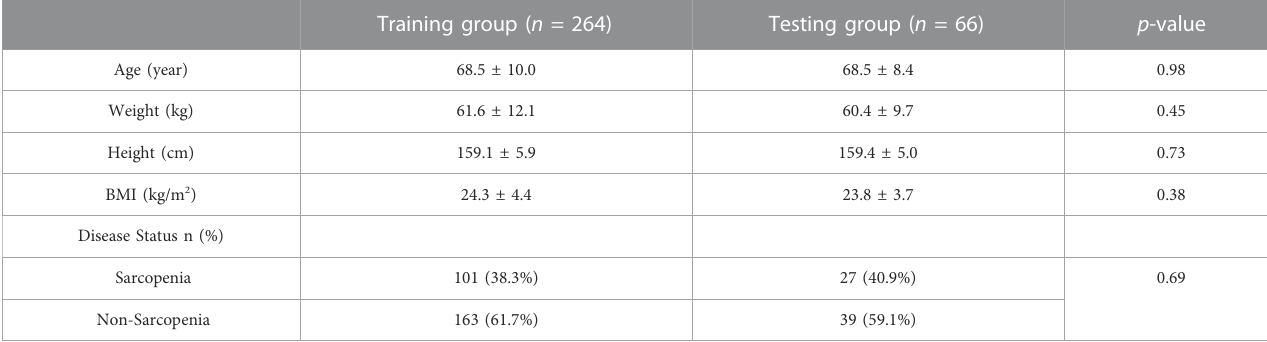
TABLE 1 Demographic characteristics in this